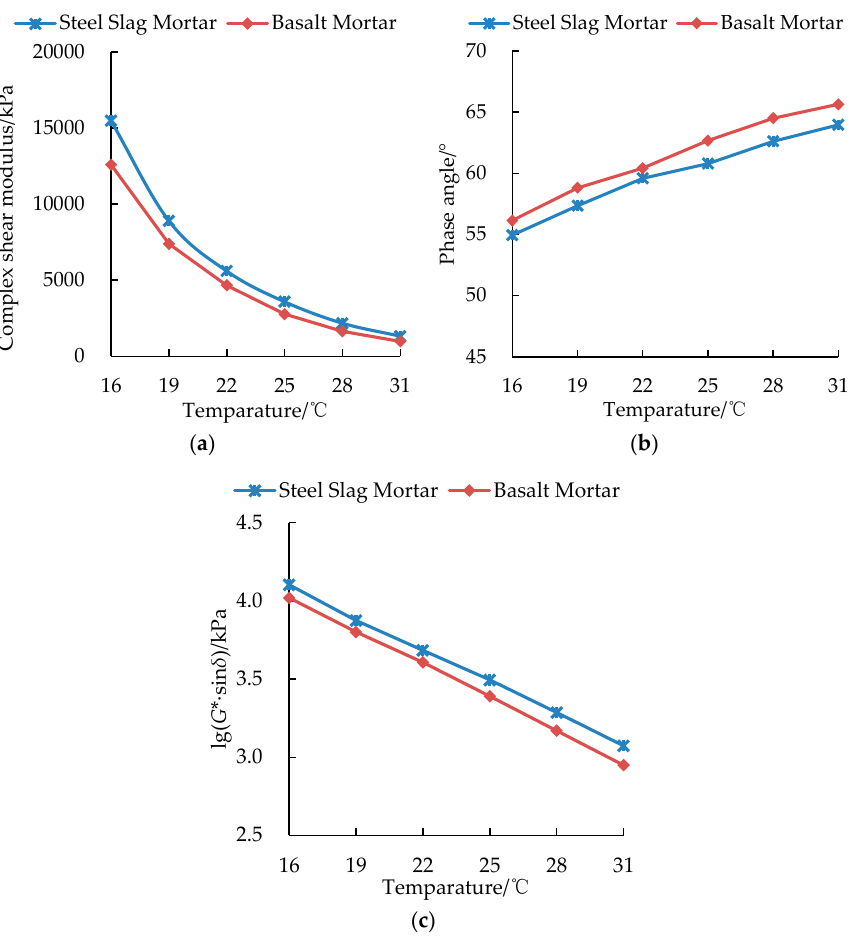
Figure 3. Intermediate-temperature rheological property results: ( a ) complex shear modulus; ( b ) phase angle; ( c ) fatigue crack resistance parameter.